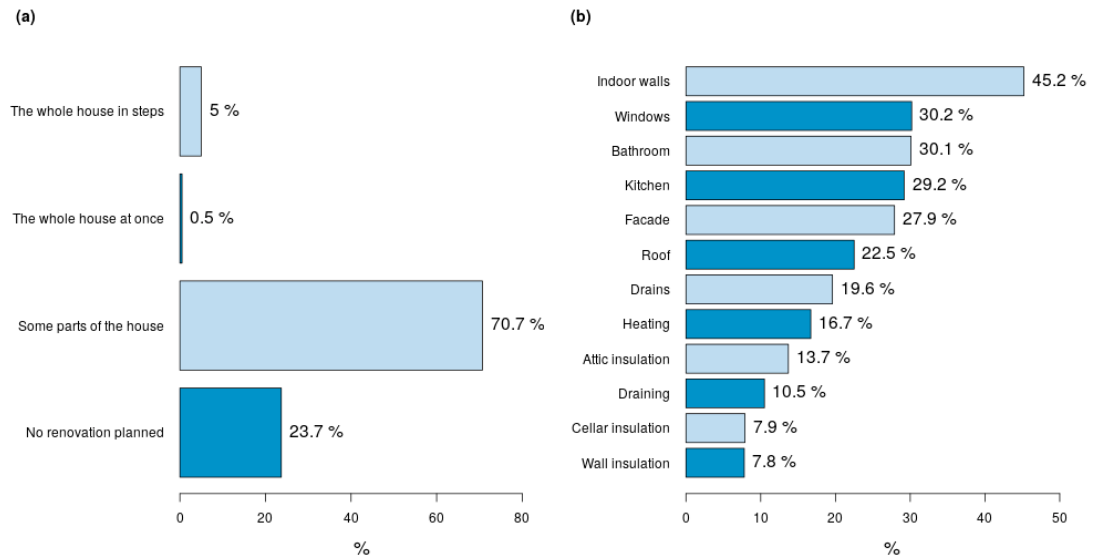
Figure 2. Frequency distribution for the renovation prospects as a whole ( a ) and the items that respondents are planning to renew ( b ).